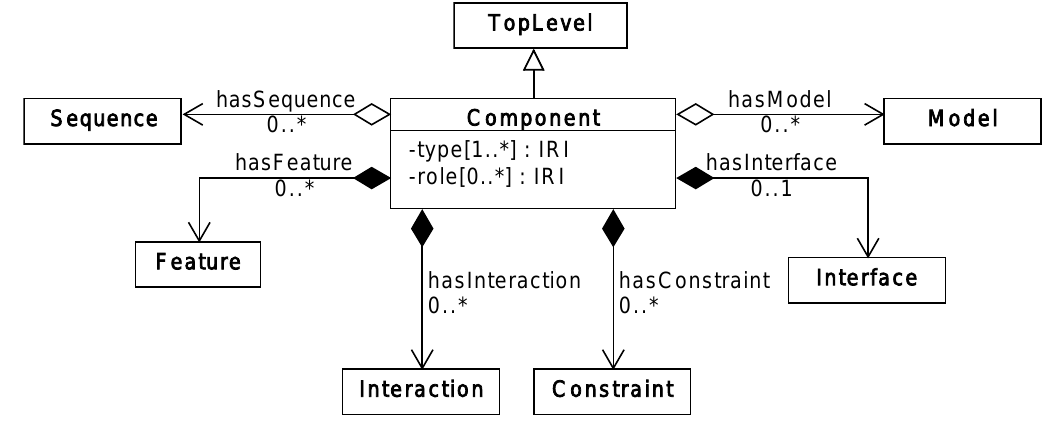
Figure 8: Diagram of the Component class and its associated